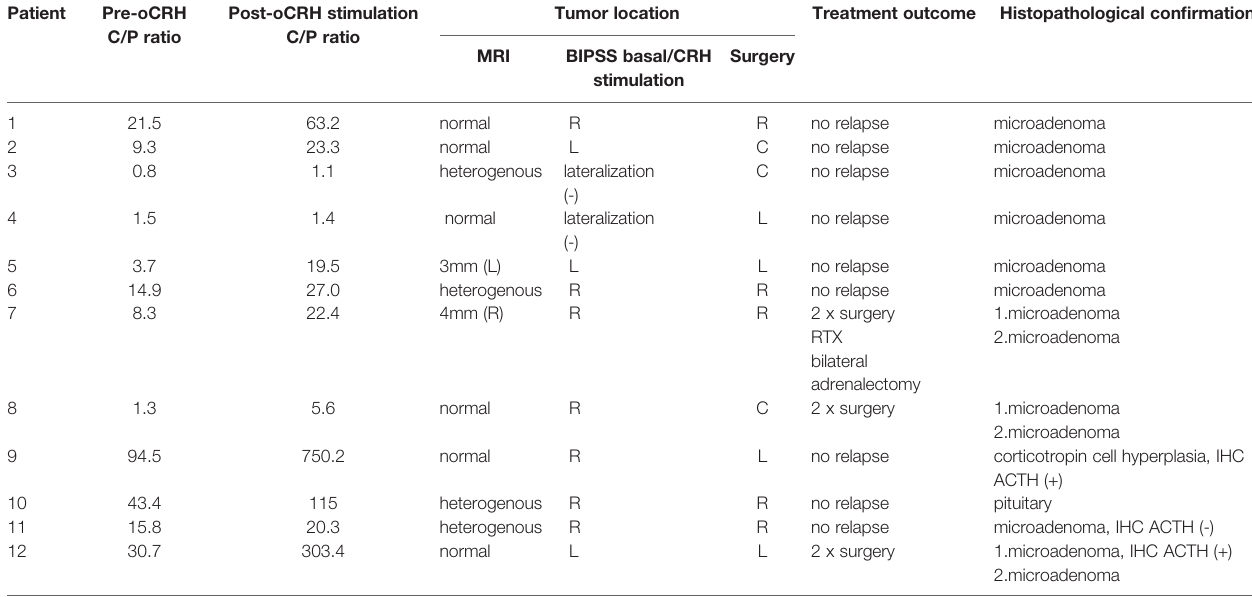
TABLE 1 | BIPSS results in pediatric population with Cushing